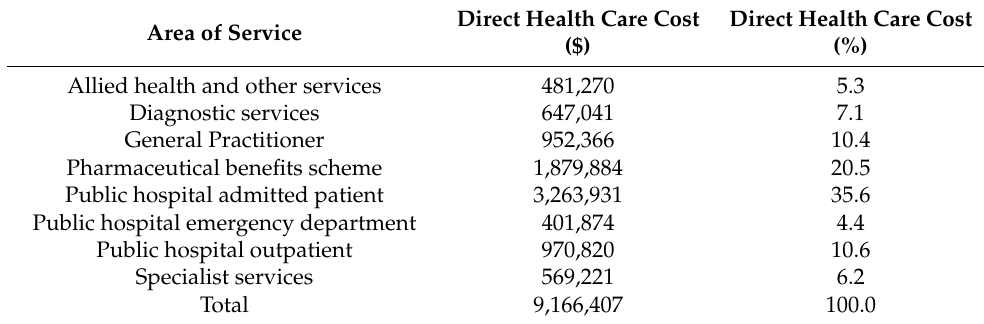
Table 3. Additional direct health care costs incurred due to LHL for those with a chronic condition (by area of health service) in the Blacktown LGA (Domain 6).